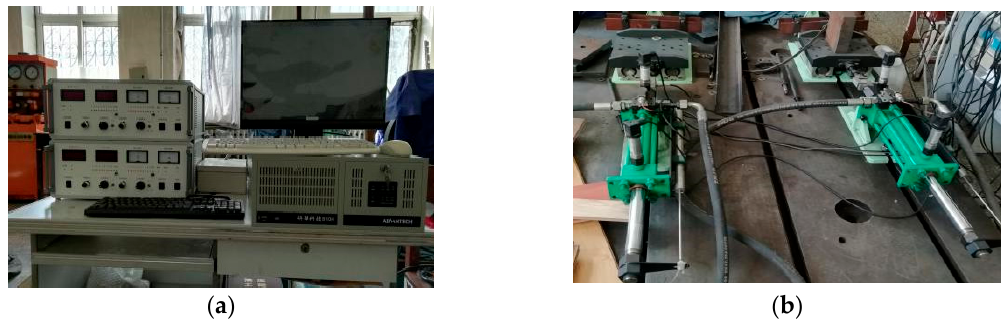
Figure 9. The electro-hydraulic semi-physical experiment platform. ( a ) Experiment platform. ( b ) Electro-hydraulic servo system.